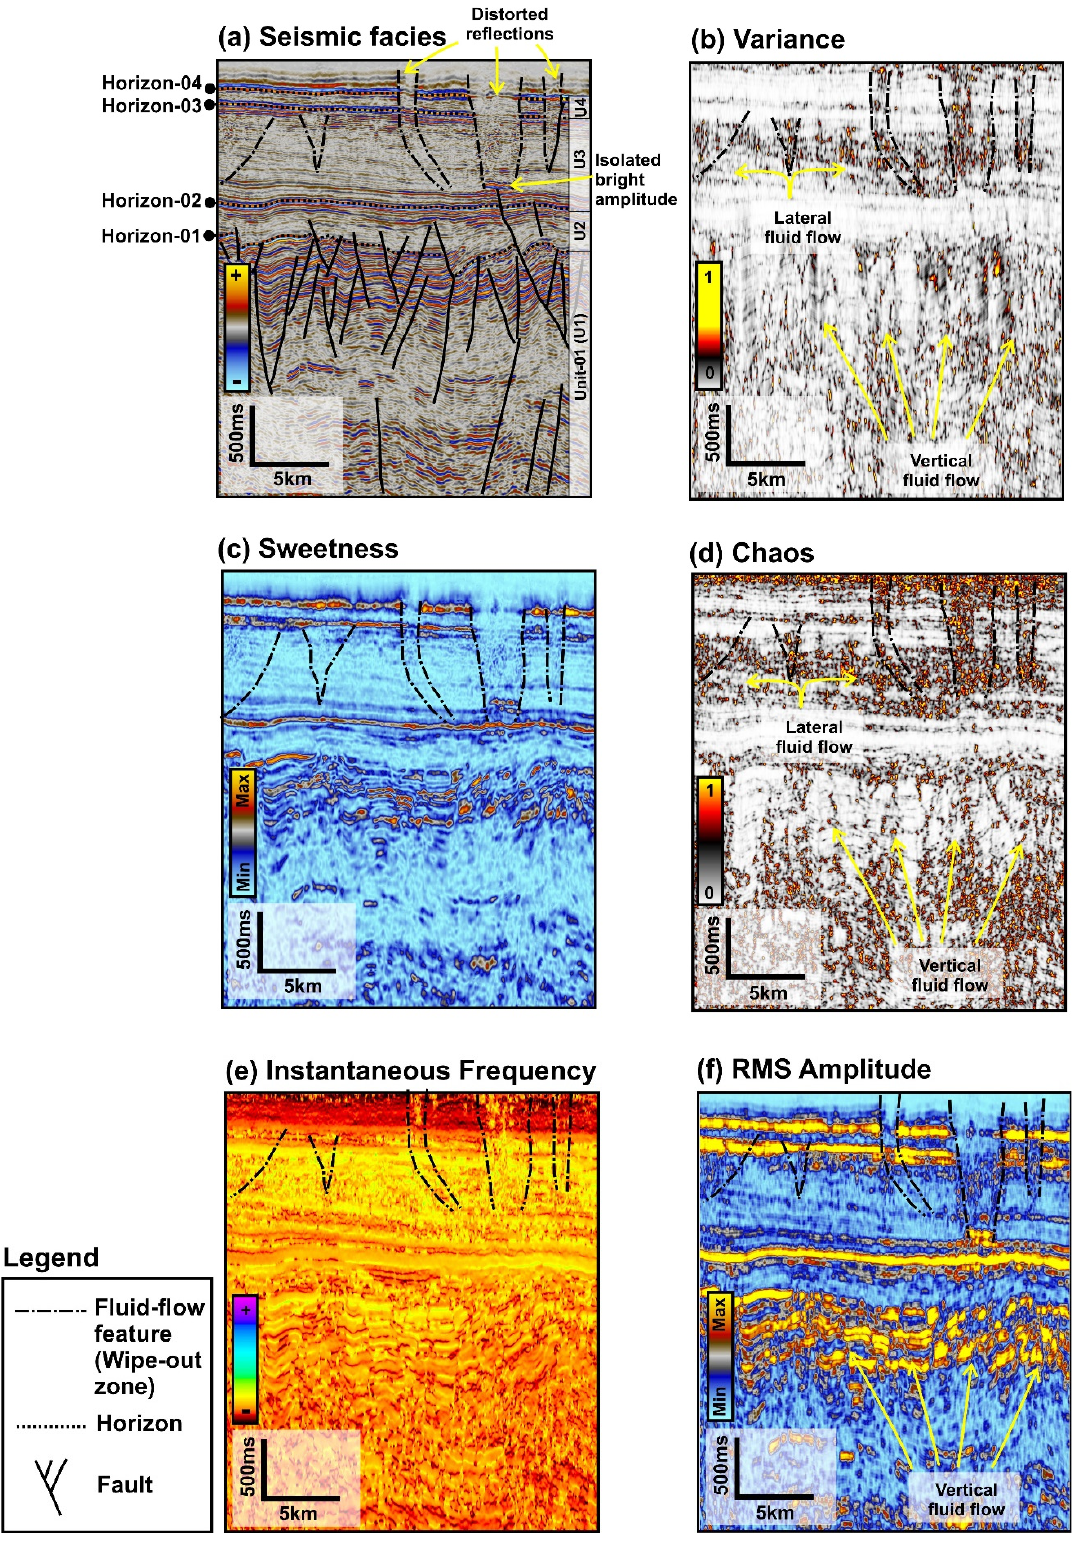
Figure 3. ( a ) Seismic facies and seismic attributes of line 2; ( b ) variance, ( c ) sweetness, ( d ) chaos, ( e ) instantaneous frequency, and ( f ) RMS amplitude, with fluid flow feature interpretation. See Figure 1a for section location.